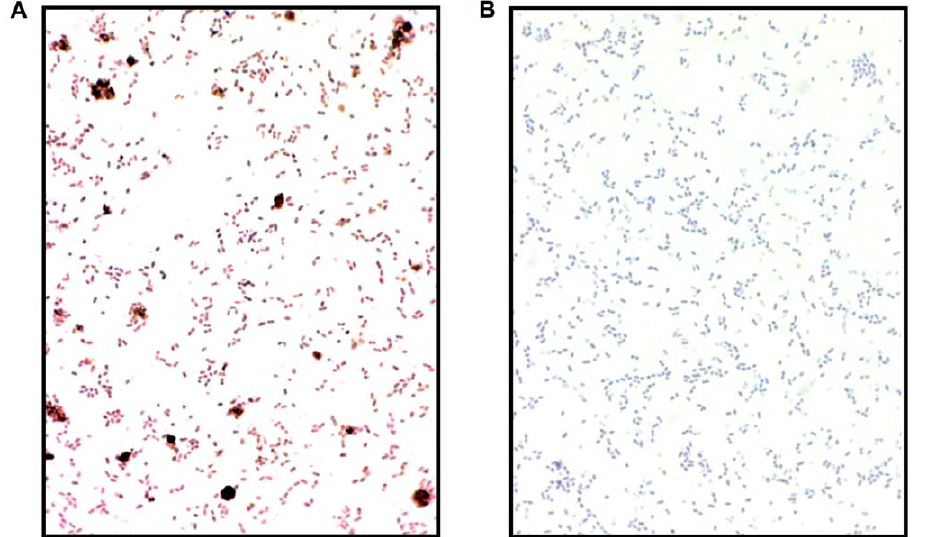
Figure 2. E.faecalis pre-incubated with A b 42 are mAb 6E10 immunoreactive. Bacteria were incubated (1 hr at 37 u C) with ( panel A ) or without ( panel B ) A b 42 (25 m g/ml). Following repeated washes, the bacteria were fixed onto glass slides and immunostained with the HRP